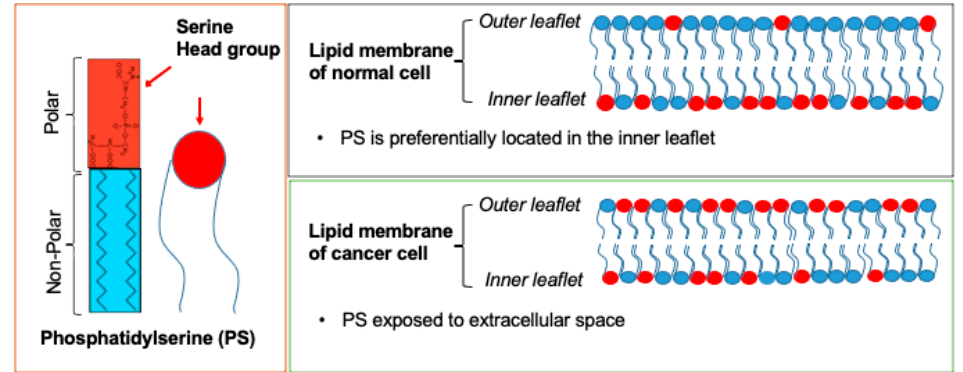
Figure 1. Schematic representation of phosphatidylserine (PS) and its distribution on normal and cancer cells.